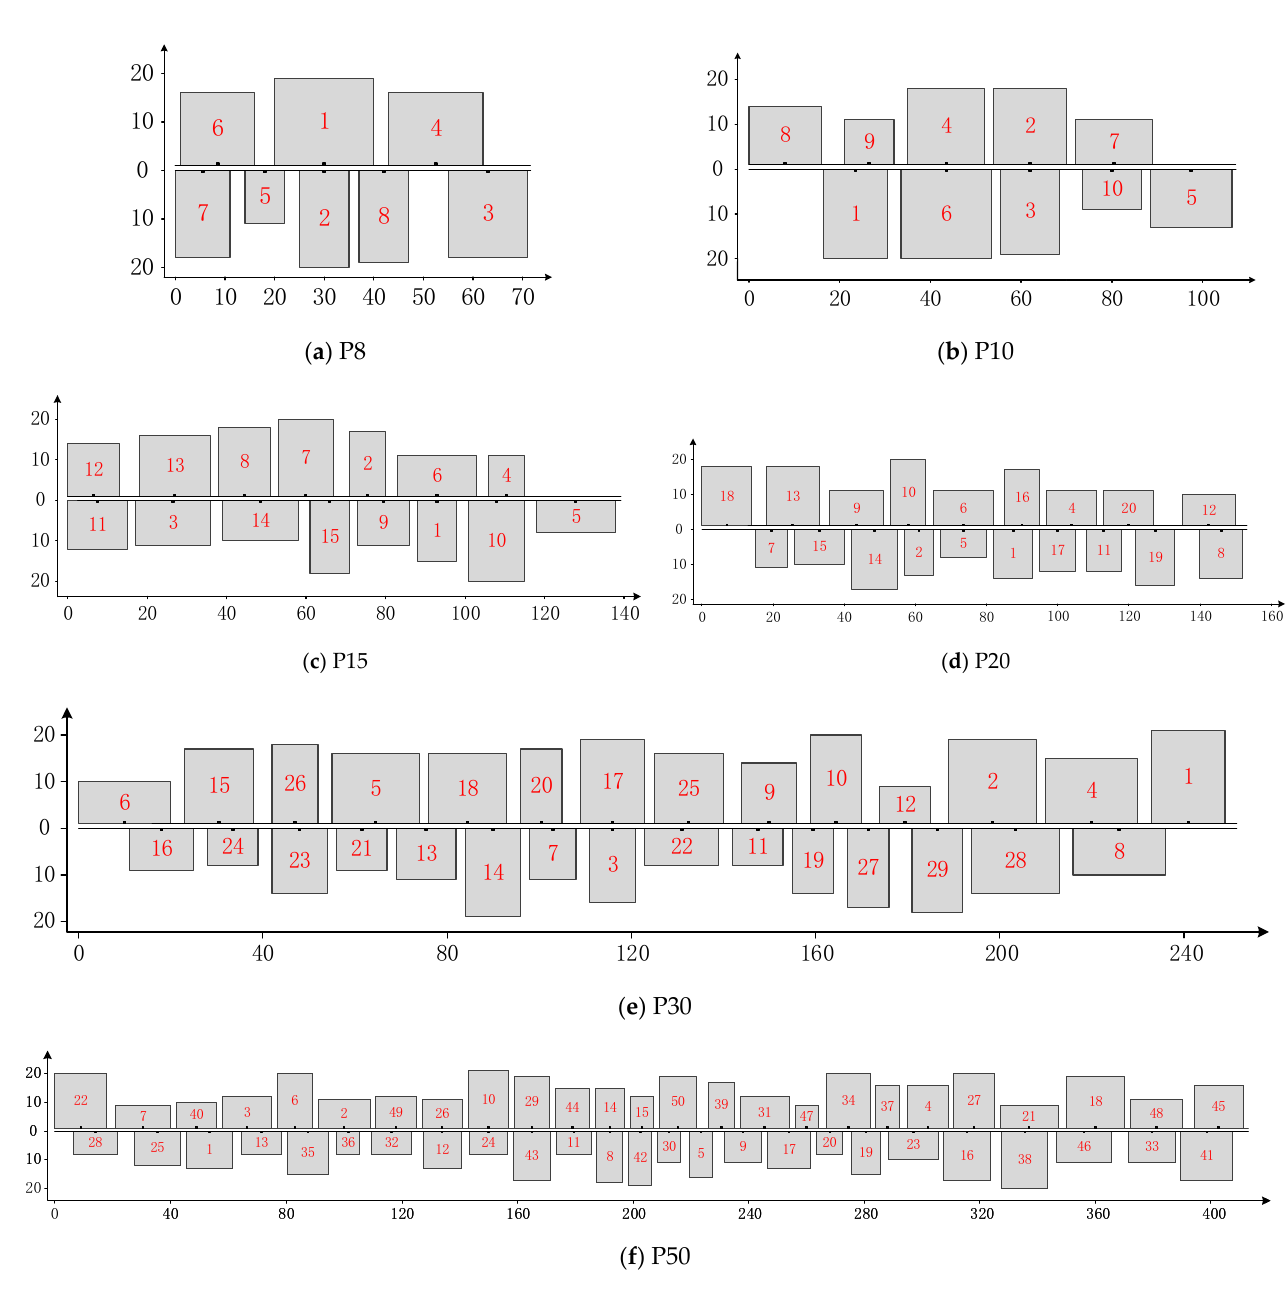
Figure 6. The best solutions found by LS-EA for all problem instances. As the problem size increases, the computational time required for EM increases greatly. The EM can only find the optimal solutions of LP 2 for P8 and P10. For other prob- lem instances, the EM is able to find the feasible solutions within the given runtime. With the increase of scale of problem instances, LS-EA and HS-LP have significant advantages over EM. Although HS-LP is given longer runtime than LS-EA, LS-EA outperforms HS- LP in terms of average material handling cost on all problem instances except for P8. The best solutions (layouts) found by LS-EA for all problem instances are shown in Figure 6.